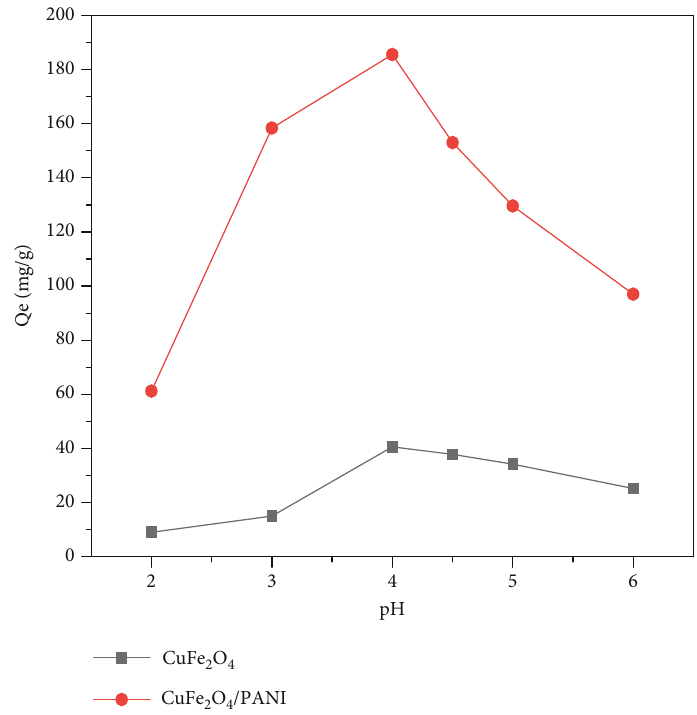
Figure 7: E ff ect of initial pH value of solution on the adsorption of UO